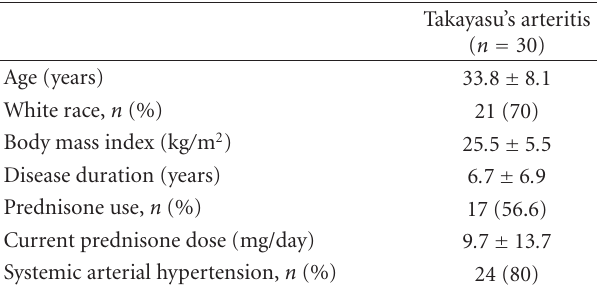
Table 1: Demographic, clinical features and prednisone use of patients with Takayasu’s arteritis. Values are expressed in mean ± SD or percentage (%).